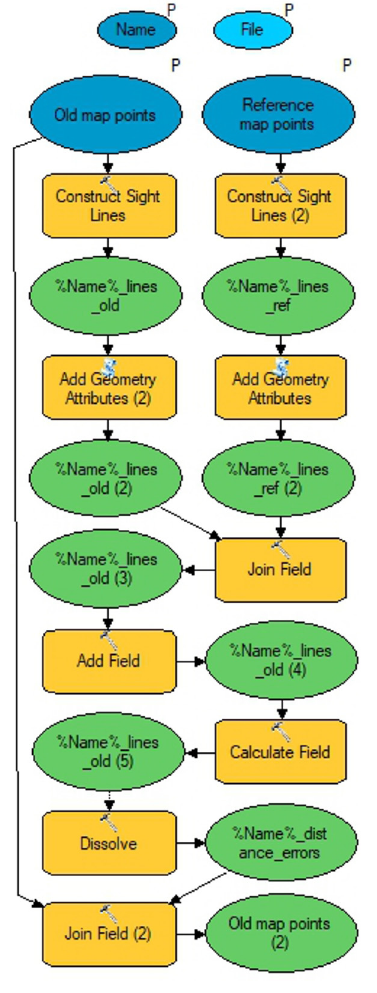
Fig. 1. Model of data flow between geoprocessing tools presenting the procedure of old map distance analysis (source: M. Palczewski